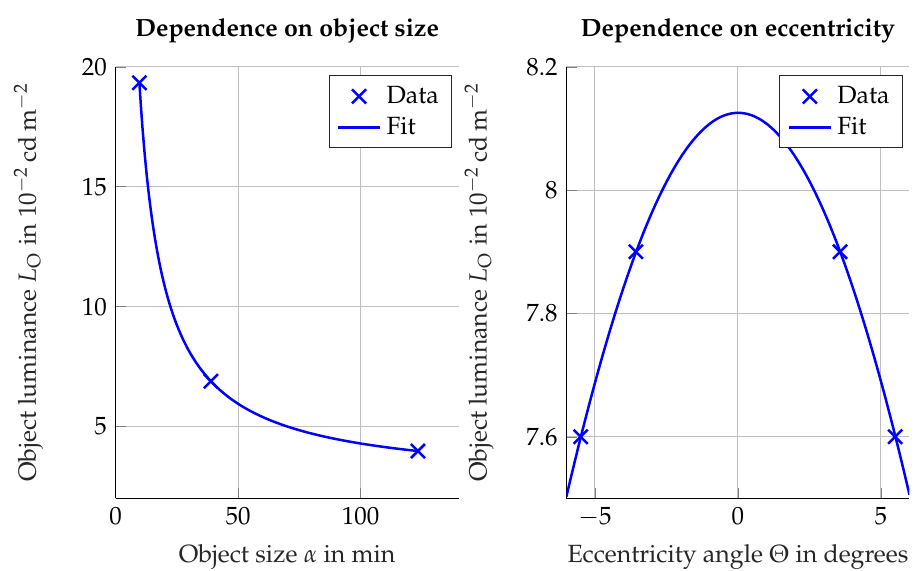
Figure 3. Dependence of the required object luminance L O on the object size α ( left ) and the eccentric- ity angle Θ ( right ) according to Damasky [18]; both with increasing object size α and with increasing eccentricity angle Θ the object luminance L O required for detection decreases; for both fit functions, the coefficient of determination R 2 is greater than 0.99